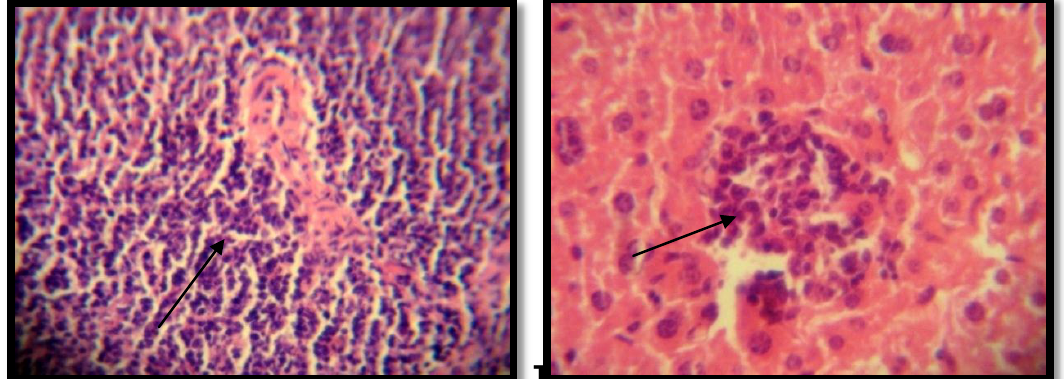
Figure5: Spleen of mouse treated with 16mg/kg bw of pentoxifylline for1month showing moderate hyperplasia of lymphoid tissue of white pulp